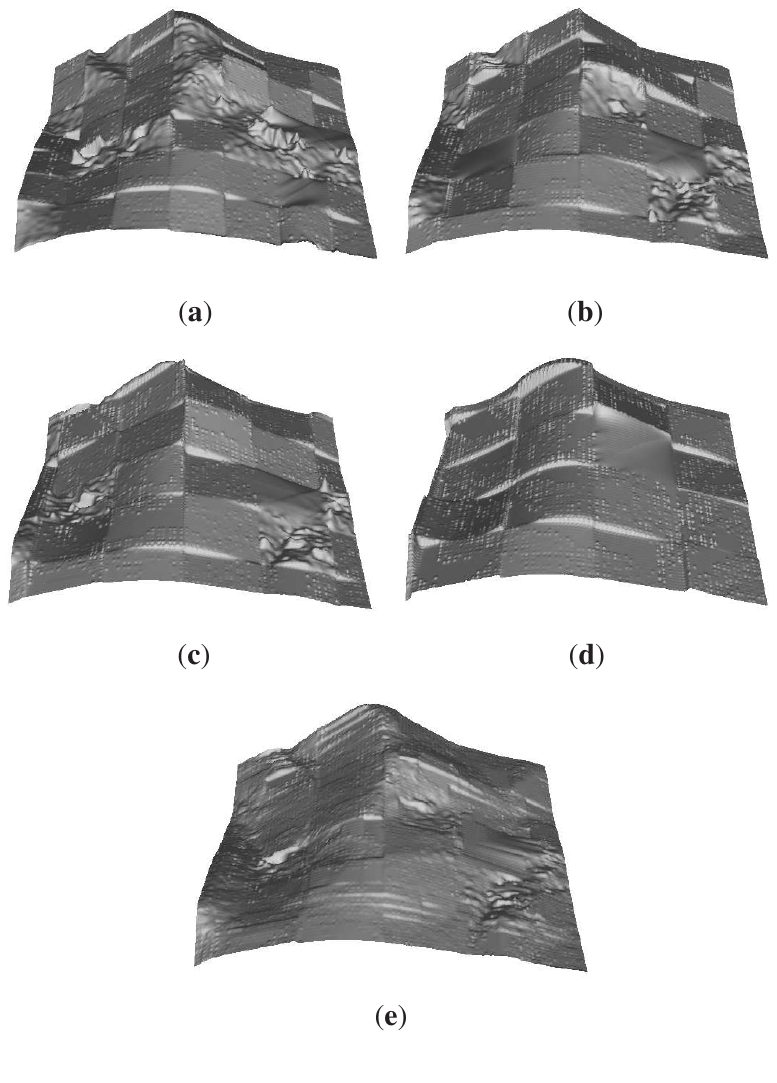
Figure 7. Combining four DTMs (a) Patch width = 50; (b) Patch width = 60; (c) Patch width = 70; (d) Patch width = 80 generated using different patch widths to produce the final DTM (e) After combining and removing jumps. Each DTM sample measures approximately 350 m in